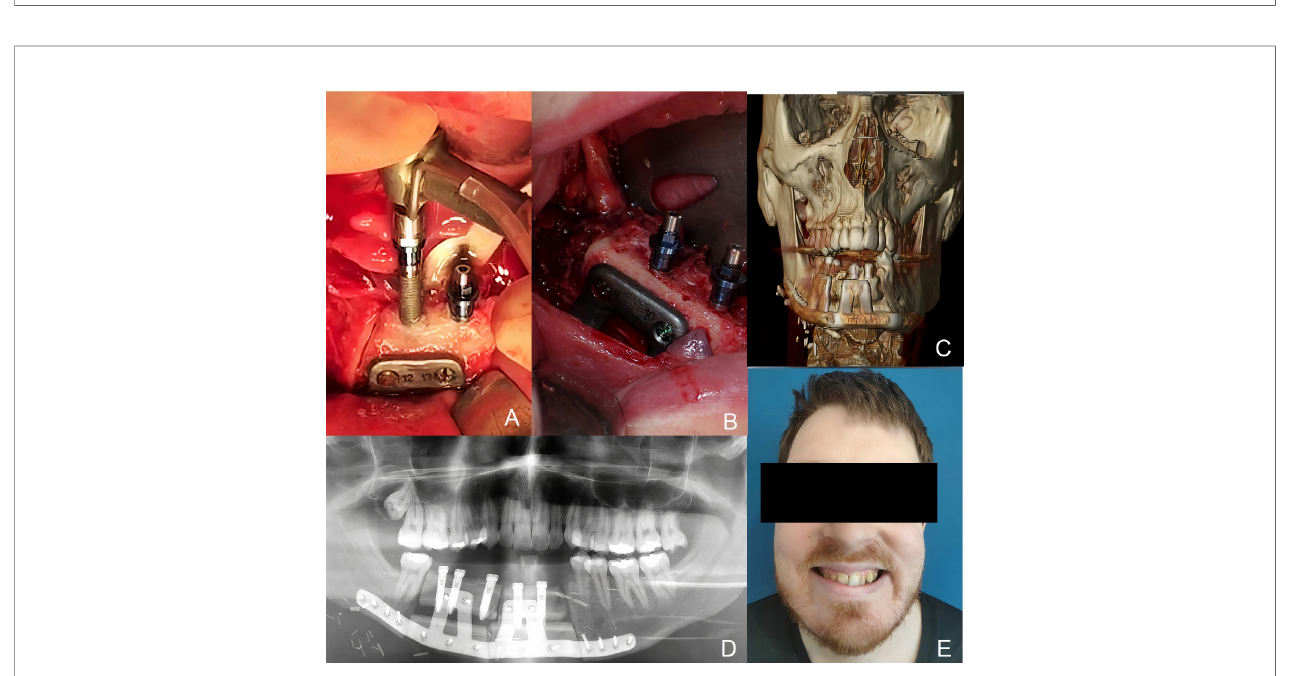
FIGURE 4 | (A, B) Immediate implant placement between the osteosynthesis material as previously planned in the VSP. (C) Postoperative CT scan demonstrating the 3D reconstruction with the double-barrel free fl ap, the double-barrel customized plate and the immediate implants. (D) Panoramic radiograph after surgery with 3D reconstruction of the mandible. (E) Final aesthetic and functional